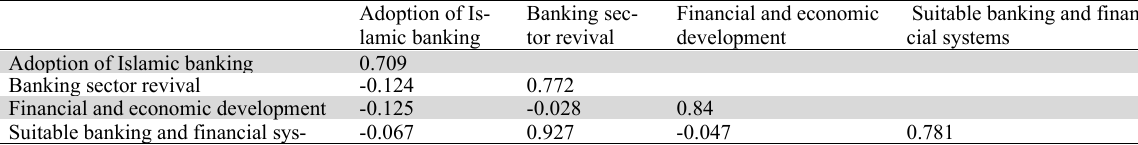
Fornell-Lacker criterion analysis for checking discriminant validity